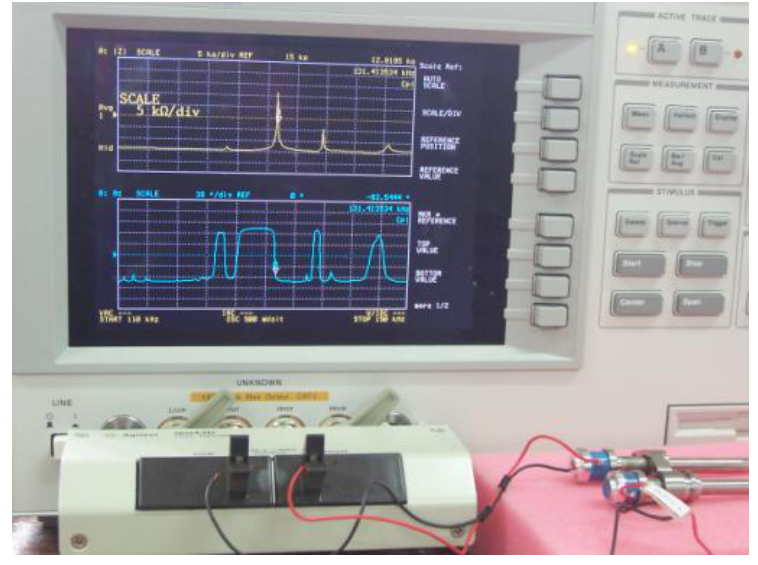
Figure 12. The experiment system for impedance measurement via Agilent 4294